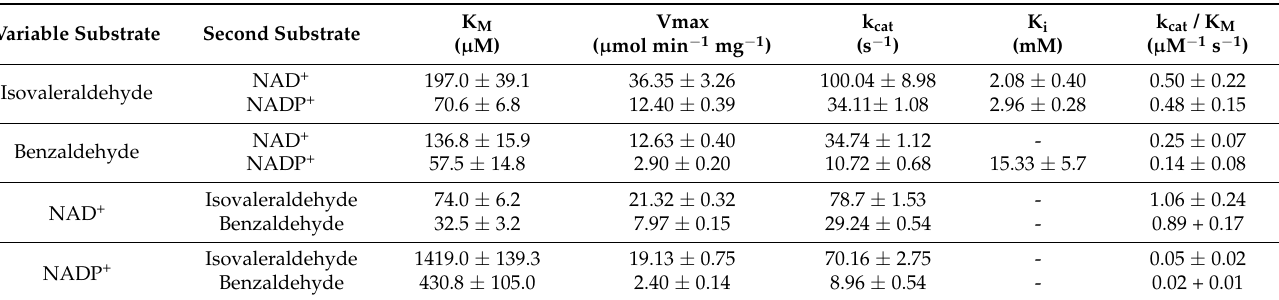
Table 3. Steady state kinetic parameters of